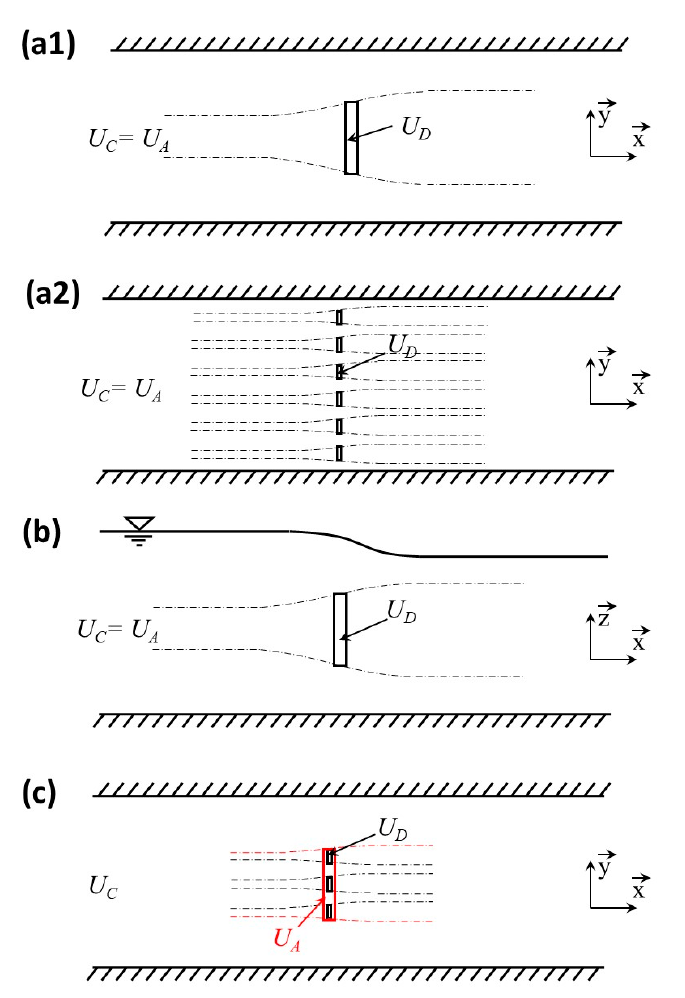
Figure 3. Schematic representation of the analytical models. ( a1 ) G&C2007 applied to a single tur- bine, ( a2 ) G&C2007 applied to a fence of turbines arrayed uniformly across the channel, ( b ) W2009, and ( c ) N&W2012. ( c ) The dashed red curves represent the stream tube passing through the fence of turbines (surrounded by a red rectangle), and represent the flow at the “array scale”. The dashed black curves represent the stream tube passing through each turbine, and represent the flow at the “turbine scale”. U D is the velocity in the disk, U A is the velocity at the fence, and U C is the channel cross-sectional average of the streamwise velocity.